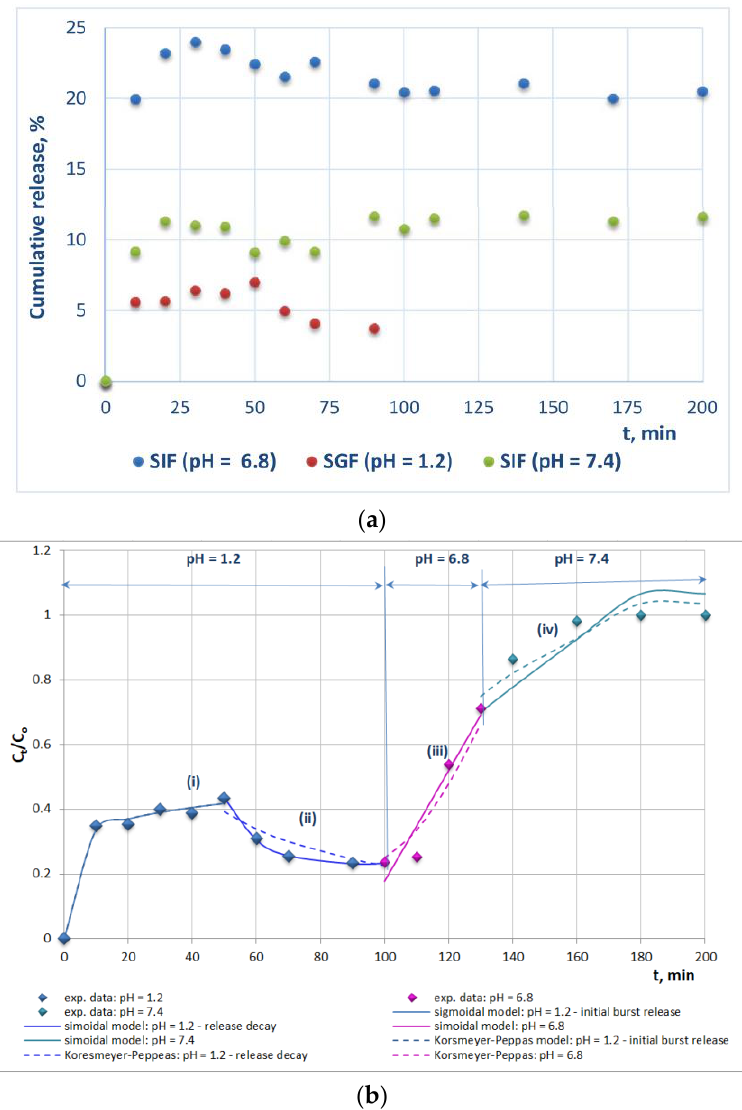
Figure 6. In vitro release kinetic curves of morin from LMPs: ( a ) experimental release kinetic curves in the three simulated physiological compartments; ( b ) experimental and model release profile throughout the simulated gastrointestinal tract—Korsmeyer–Peppas and sigmoidal model: (i) initial burst release in SGF; (ii) release decay in SGF; (iii) intensive release in SIF at pH = 6.8; (iv) slow and sustained release in the colon at pH = 7.4.